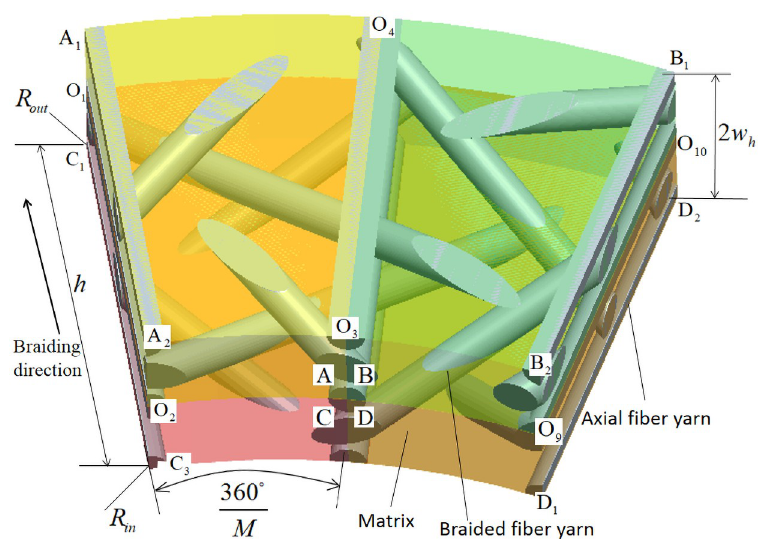
Fig 4. Internal unit cell matrix and fiber yarn.